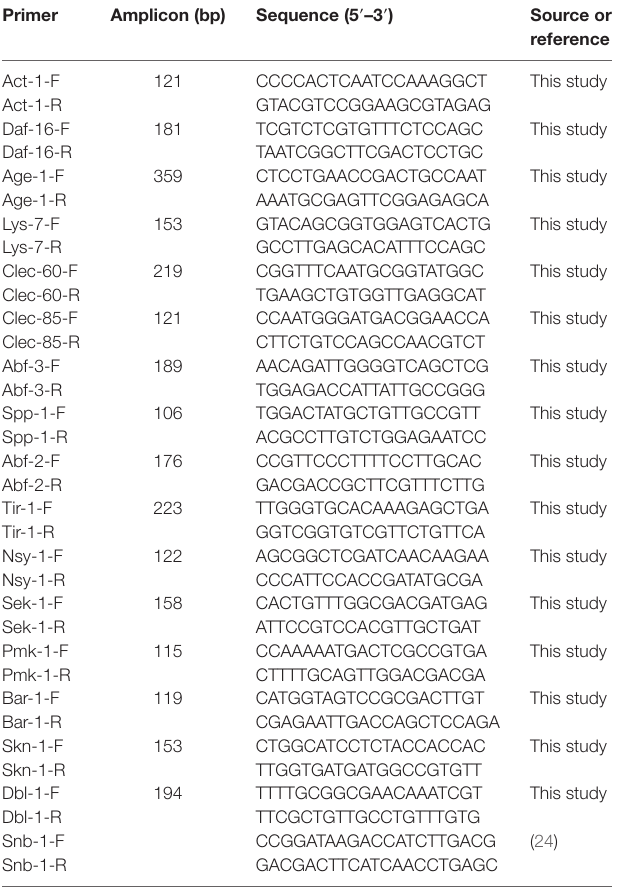
TaBle 1 | Primers of QPCR assay a